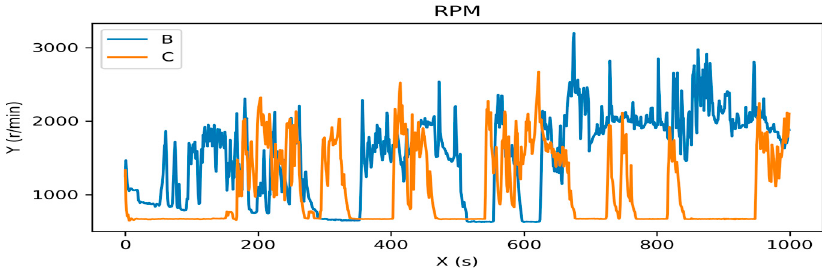
Figure 3. The visualization of revolutions per minute (RPM) of drivers B and C.